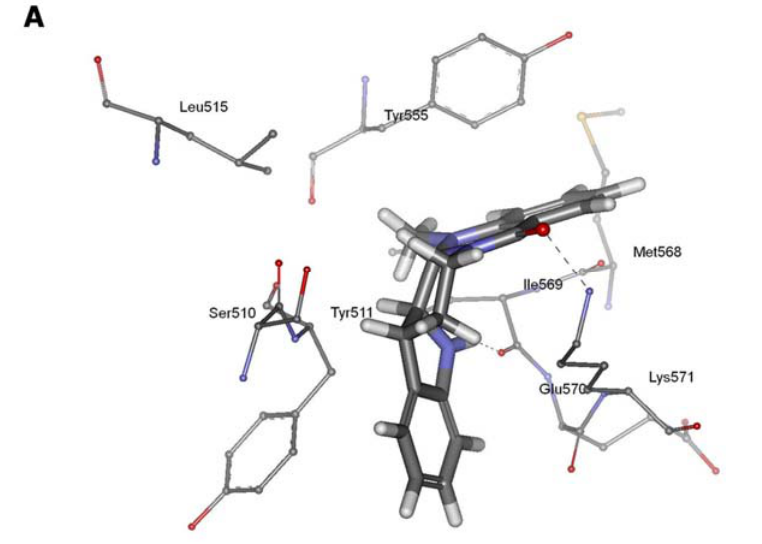
Figure 4. Binding of evodiamine to the active sites of rat ( A ), human ( B ) and rabbit ( C ) TRPV1